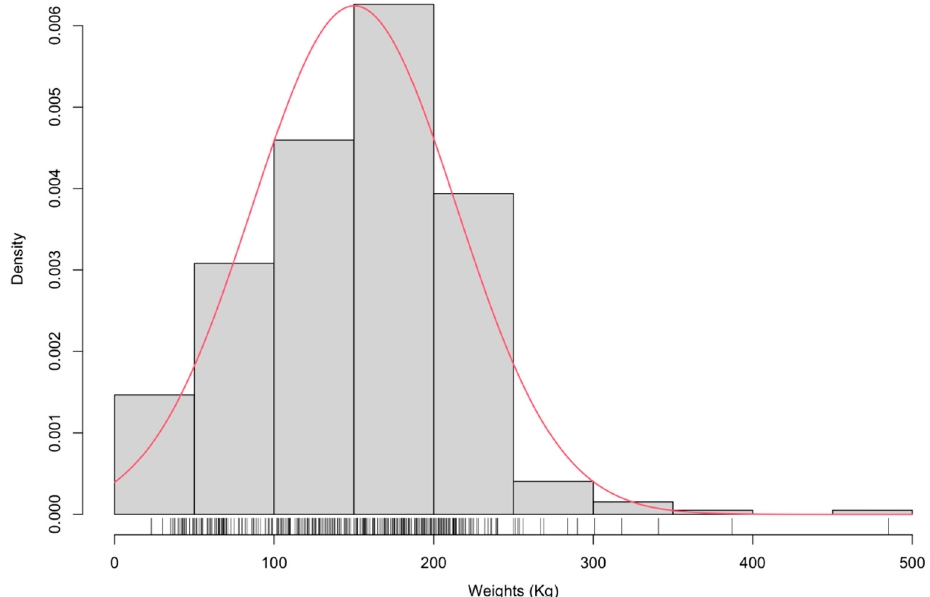
Figure 1. The distribution of body weights in 2019. In total 406 weights of individuals yaks were observed from 23 to 485 Kg. The density of phenotype values was drawn as vertical bar. The red line fits normal distribution.